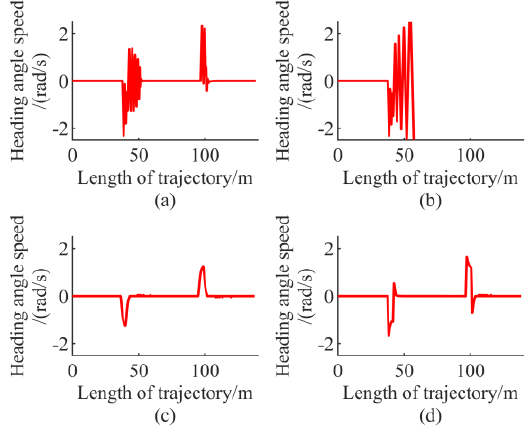
Figure 9. The heading angle speed when velocity is 3 m/s. ( a ) LMPC. ( b ) LEMPC. ( c ) NMPC. ( d ) NEMPC.